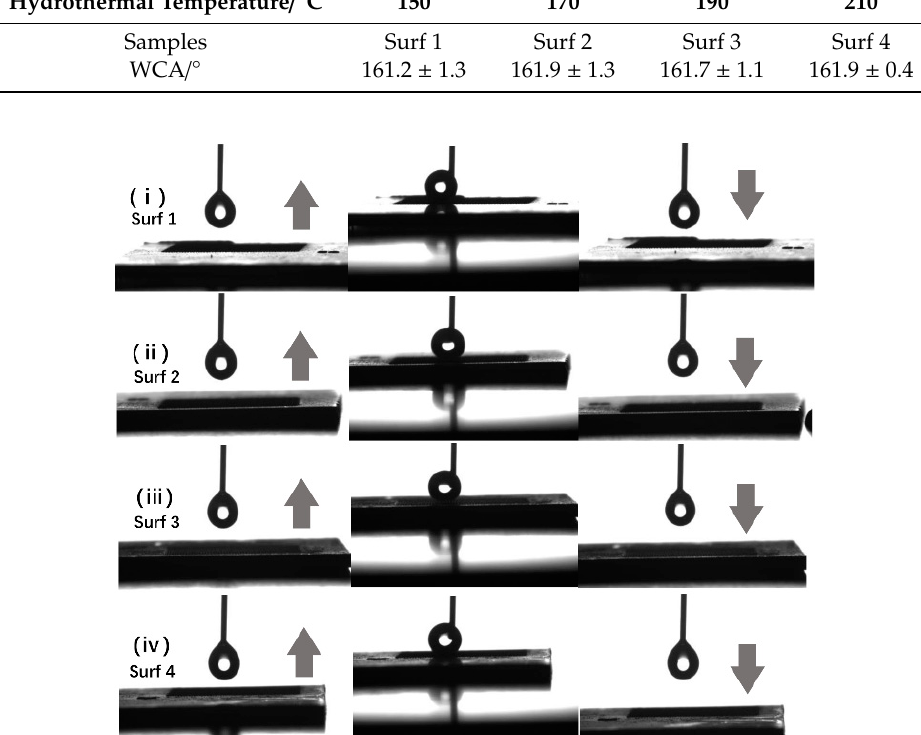
Figure 5. Surface water droplet adhesion test corresponding to different hydrothermal temperatures of micro/nano hierarchical structures: ( i ) Surf 1: 150 °C; ( ii ) Surf 2: 170 °C; ( iii ) Surf 3: 190 °C; ( iv ) Surf micro / nano hierarchical structures: ( i ) Surf 1: 150 ◦ C; ( ii ) Surf 2: 170 ◦ C; ( iii ) Surf 3: 190 ◦ C; ( iv ) Surf 4: 4: 210 °C. 210 ◦